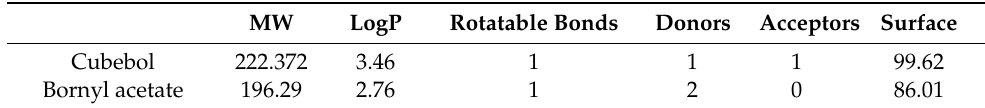
Table 6. Physicochemical parameters (Lipinski Rule of Five) of cubebol and bornyl acetate compounds.